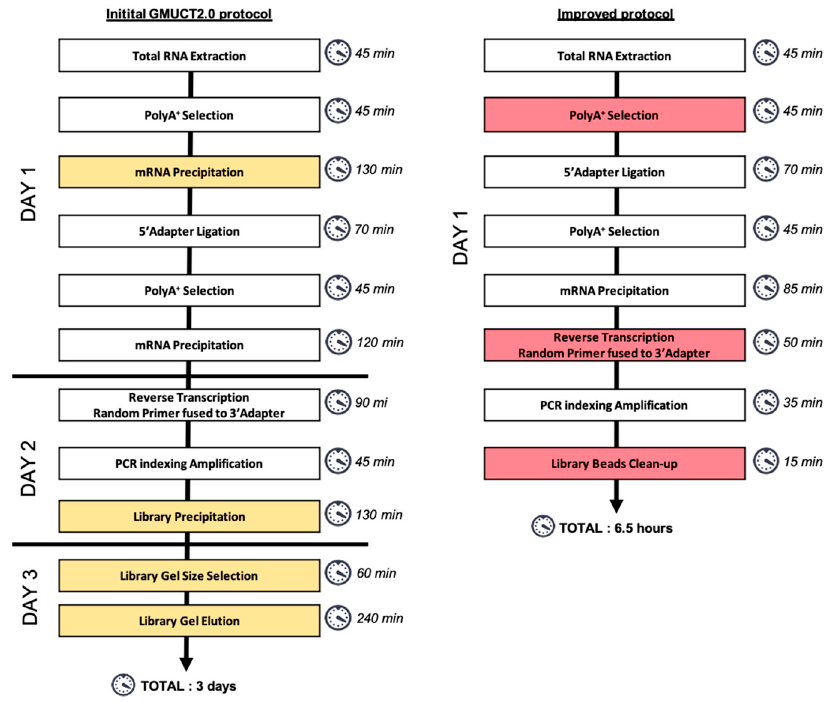
Figure 2. Comparison of the initial GMUCT2.0 and the improved protocol. The initial protocol takes 3 days and includes library gel size selection and many precipitations steps (highlighted in orange). To simplify GMUCT2.0 protocol, we adjusted volume reactions to limit precipitation steps, used a more efficient reverse transcriptase and replaced library gel size selection by a library beads clean-up (highlighted in red). Approximative duration time is indicated for each step.